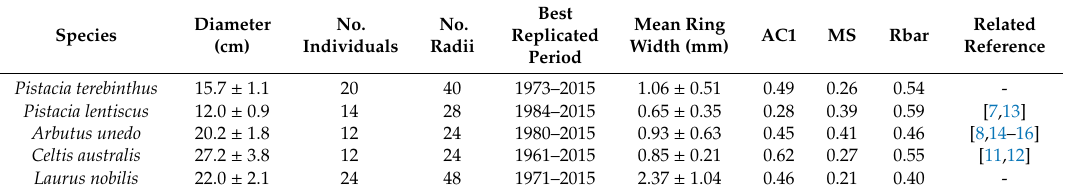
Table 1. Study species, basal diameter of sampled individuals, and ring-width statistics. Values are means ± standard deviations for the common period 1984–2015. Abbreviations: AC1, first-order autocorrelation; MS, mean sensitivity; rbar, mean correlation between indexed ring-width series. The last column indicates related bibliographic references studying the same species or sites. The best replicated period was defined as that with EPS ≥ 0.85, where EPS is the expressed population signal. Best Mean Ring Related Diameter No. No. AC1 MS Rbar Replicated Species Reference Width (mm) (cm) Individuals Radii Period Pistacia